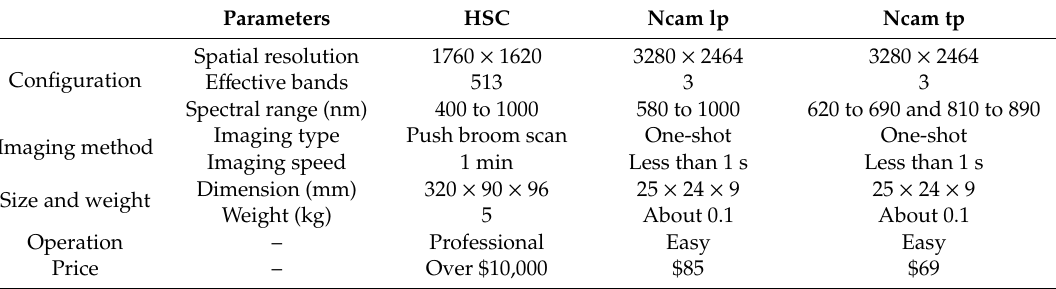
Table 3. Comparison of Ncams and HSC.